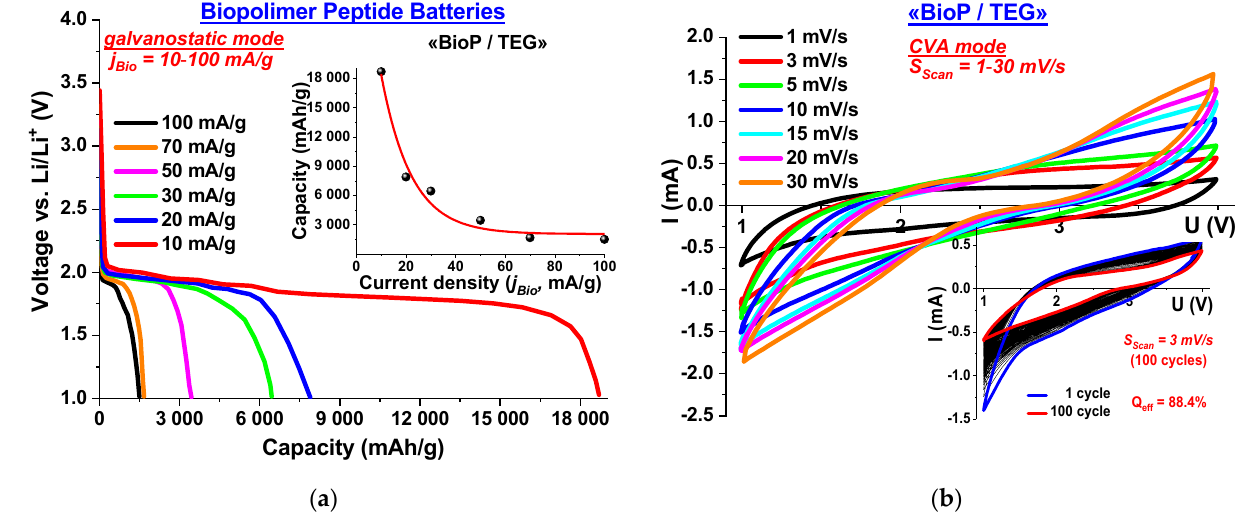
Figure 3. Electrochemical testing of ‘‘Biopolimer Peptide Batteries’’ with BioP/TEG composite cathodes: ( a ) discharge curves in galvanostatic mode for various discharge current densities of 10–100 mA/g (the inset shows the corresponding dependence of the specific battery capacity on the current density); ( b ) CVA curves for rates of potential change of 1–30 mV/s (in the inset, a sweep over 100 cycles at S Scan = 3 mV/s).